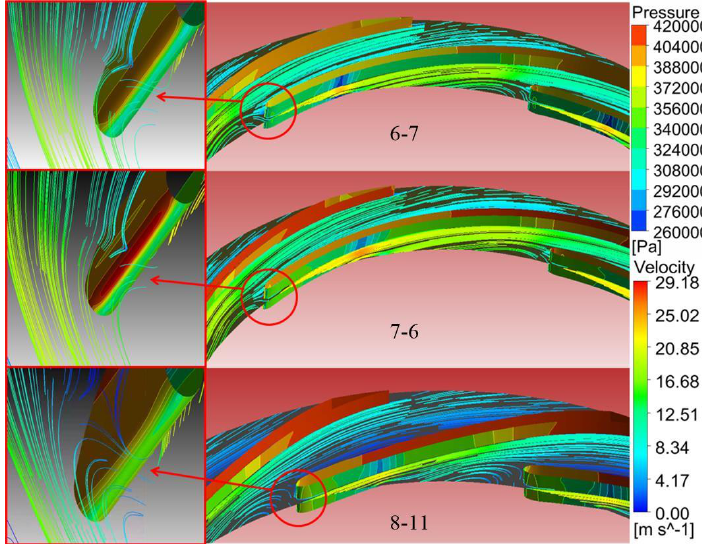
Figure 15. Static pressure distribution and velocity streamline on stay vane under different computational cases.